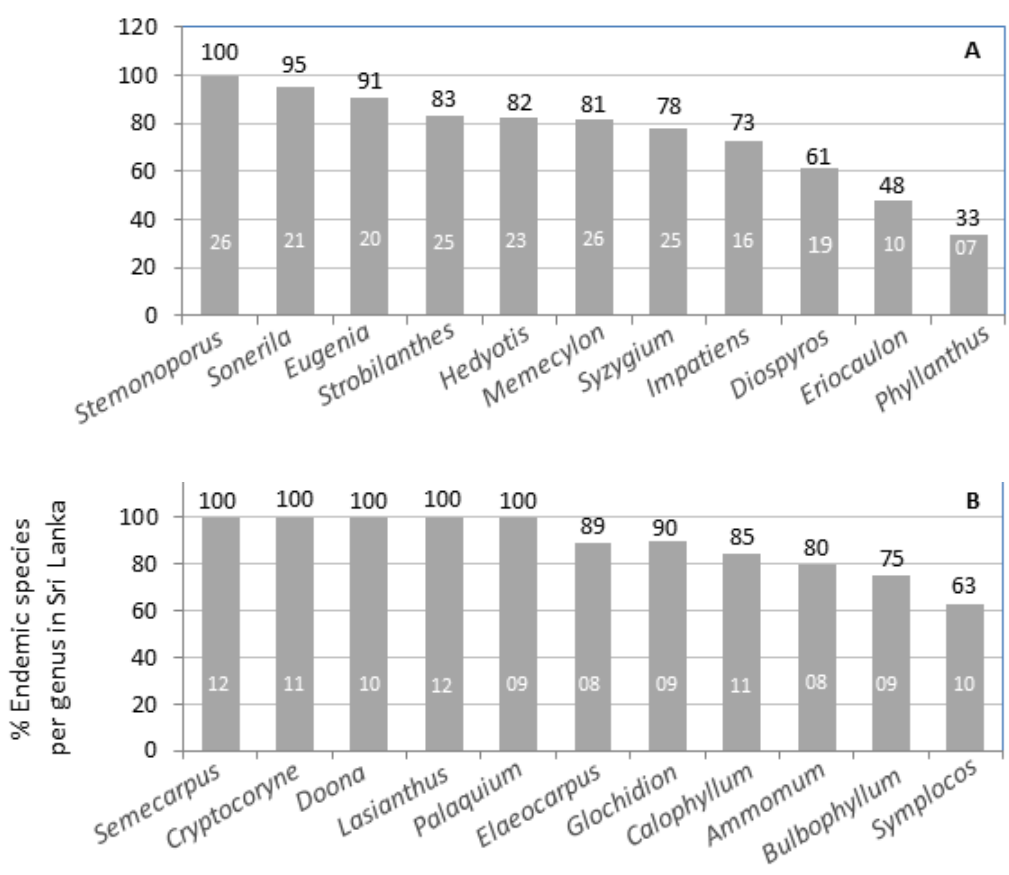
Figure 3 : Speciose plant genera with a high percent of endemics in the Sri Lankan flora most of which are restricted to SW Sri Lanka. a) Genera with > 20 species per genus and b) genera with < 20 species per genus, recorded in the island. Numbers within bars indicate the number of endemic species in each